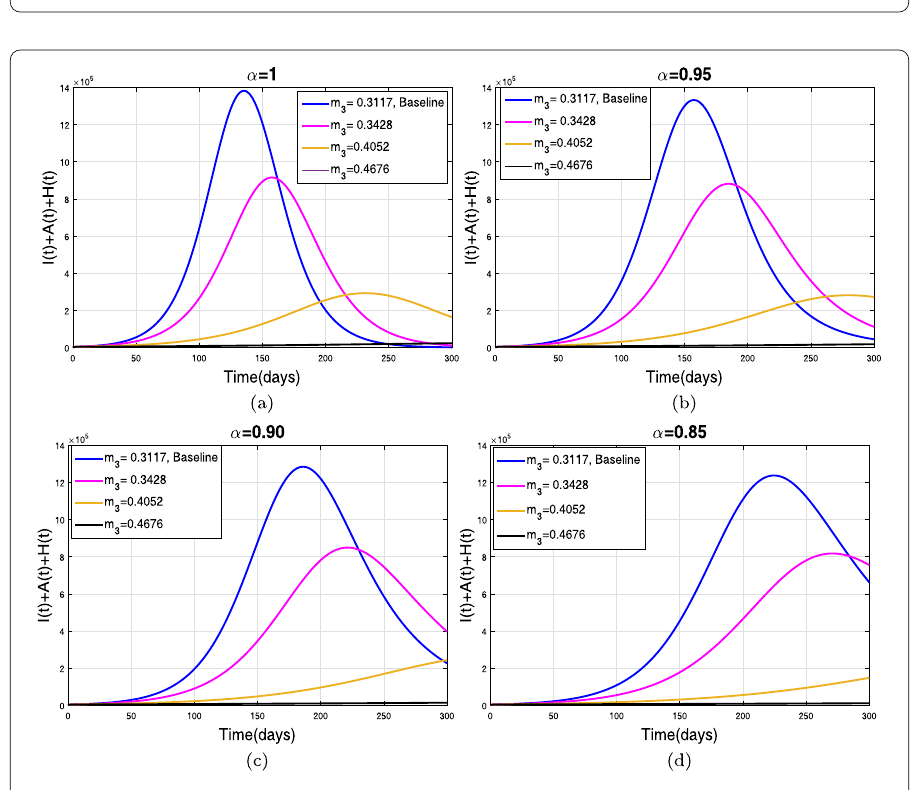
Figure 9 The impact of removal rate m 3 on symptomatic, A , and H COVID-19 individuals for α = 1, α = 0.95, α = 0.90, α =